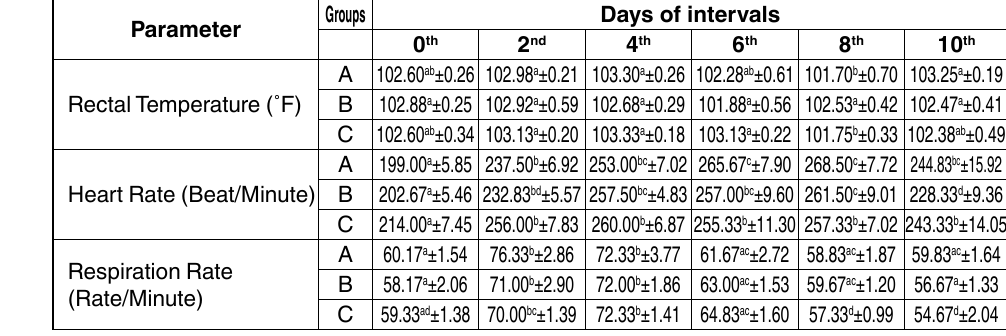
480 Pectin-honey hydrogel and olive-oil vitamin E in prevention of peritoneal adhesion.